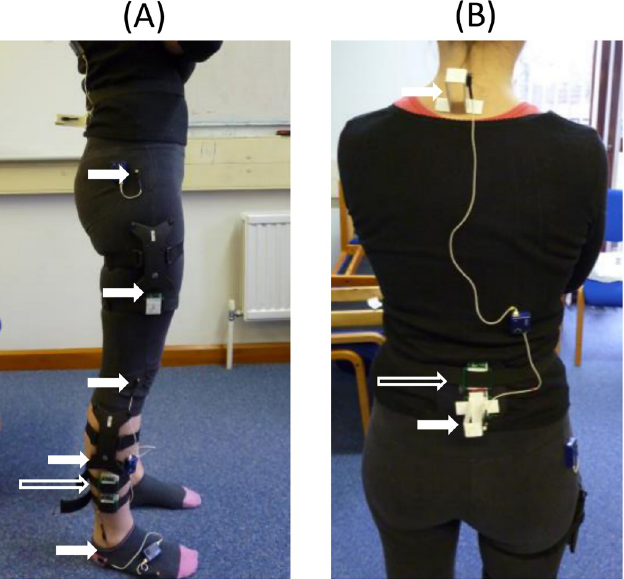
Fig 5. Full inertial wearable sensors and Codamotion marker setup. (A) Shank and thigh inertial sensors and Codamotion markers positions (B) Back inertial sensor and Codamotion marker positions. The long hollow arrows show the position of the inertial sensors placed on the shank and back. The solid short arrows show the position of Codamotion markers on the leg and the back.